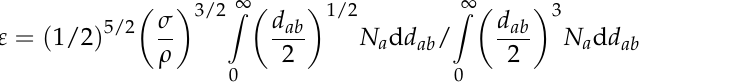
Table 3. Critical Weber numbers for the splitting of air bubbles in water flows.